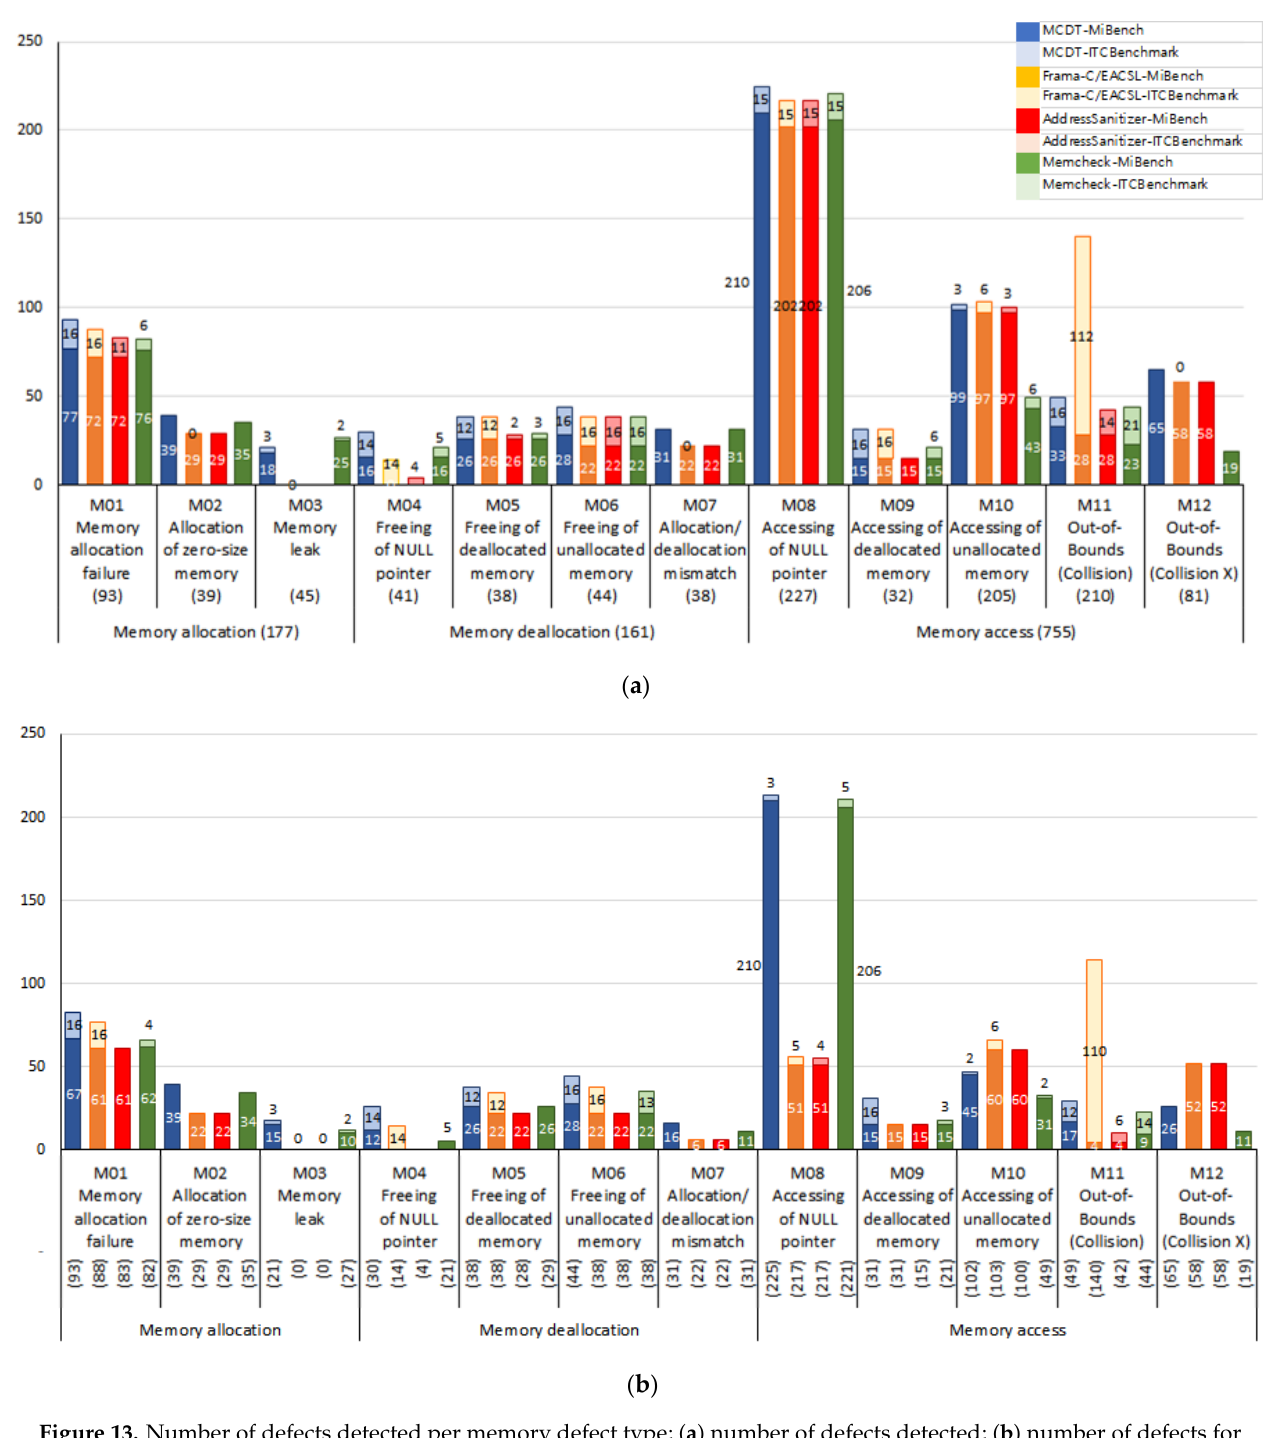
Figure 13. Number of defects detected per memory defect type; ( a ) number of defects detected; ( b ) number of defects for which the cause was accurately analyzed.